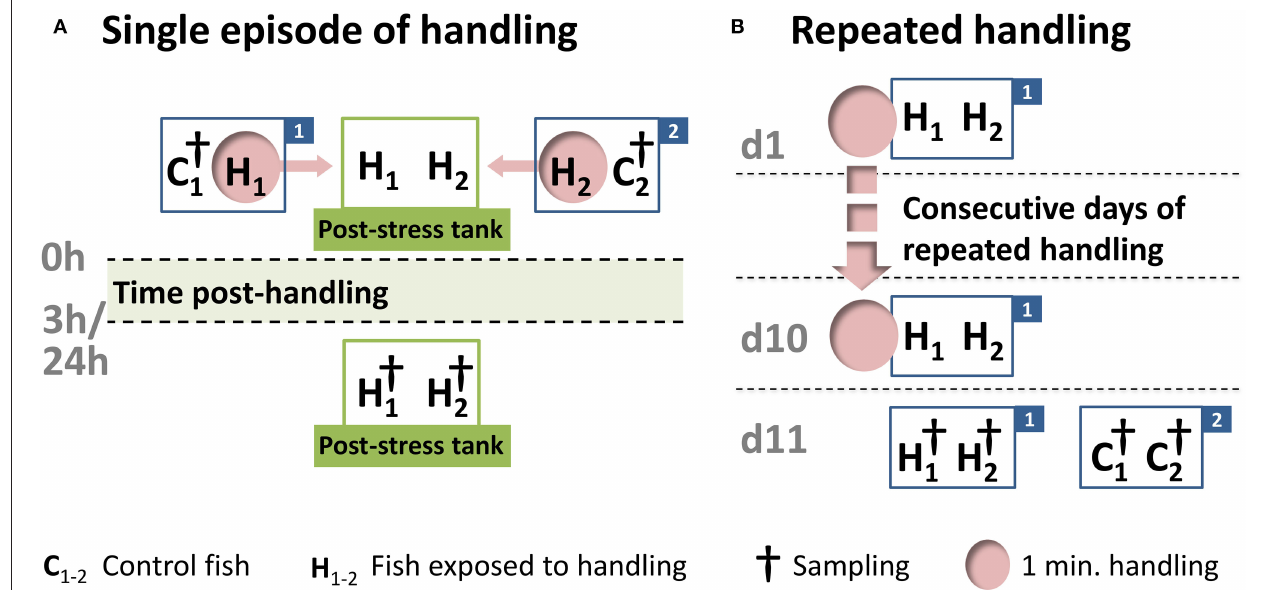
FIGURE 2 | Schematic representation of the handling experiment. After a 7-day acclimation period in the experimental tanks, 24 maraena whitefish were exposed to a one-minute handling challenge (indicated by “H” and pink circles), while 24 control fish remained undisturbed (indicated by “C”). (A) The single handling challenge involved chasing, netting, and the transfer from one tank (labeled with “1” or “2”) to another tank (termed the “post-stress tank”). Sampling (indicated by † ) was conducted at 3 or 24h after the handling challenge. This handling-challenge experiment was repeated four times, starting on different days, with rotation of the experimental tanks to avoid tank effects. A total of 16 fish were sampled per time point. (B) The repeated handling challenge was performed every morning in the same tank (labeled “1”), while the control fish (in tank “2”) remained undisturbed. After 10 days, the treated and control fish were sampled (indicated by † ). This experiment was conducted four times (16 fish in total), starting on different days and with rotation of the experimental tanks to avoid tank effects.